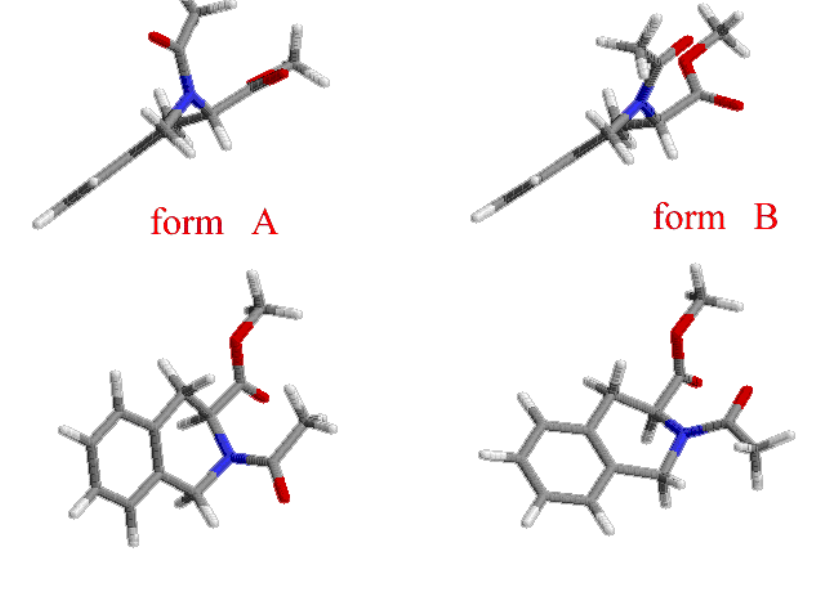
Figure 5. Structures of compound 3a optimized at B3LYP/TZVP + PCM [11-14]